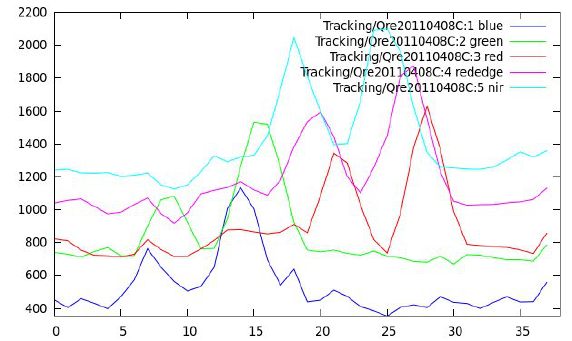
Figure 22: Profile along green line of RapidEye scene in fig. 21, reflections × 100 in [%] vs. metres along road